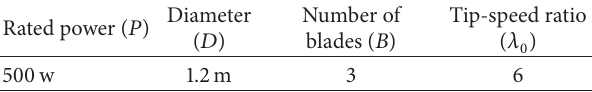
Table 2: Design parameters of the bionic